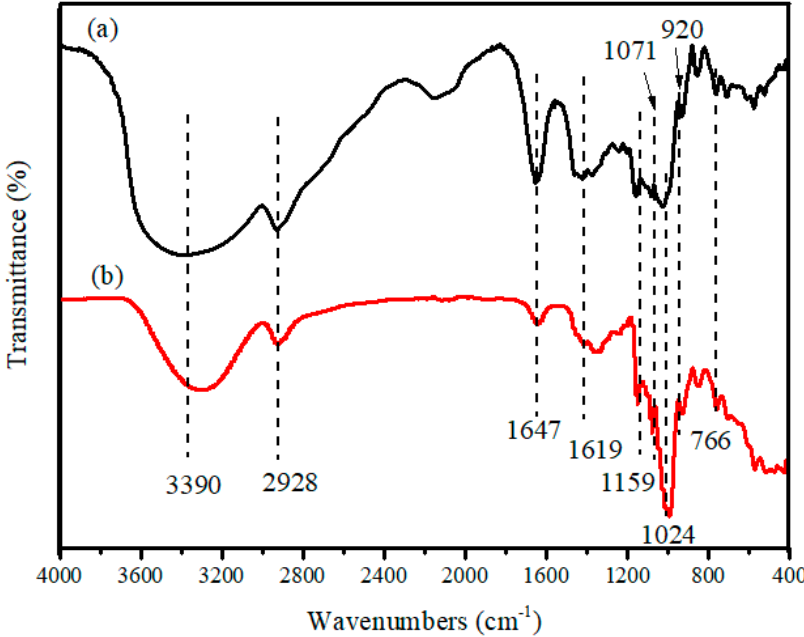
Figure 4. Fourier transform infrared (FTIR) spectroscopy spectra of binder ( a ) and corn starch ( b ).